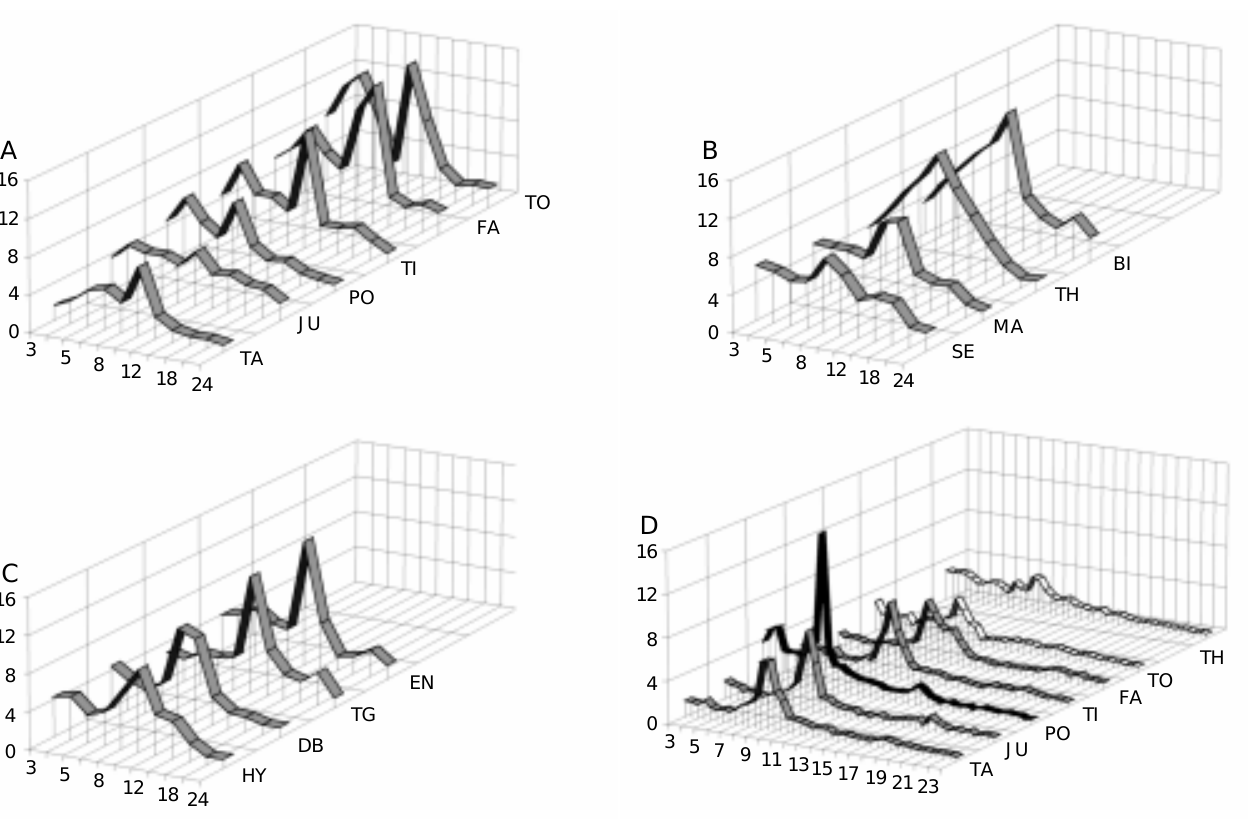
Figure 4. Individual driving profiles (first harmonic in the first series of intermittent photic stimulation) classified according to the reaction in the theta band (see Figure 1). The abscissae show the frequency of the EEG and stimulation, in Hz; the ordinates show amplitude spectra, in µv/ etc., indicate the subjects. A , Six subjects with theta peak amplitudes exceeding half their maximum in the alpha band. B , Four subjects without theta peak, but with amplitude maxima in the theta band exceeding half their maximum in the alpha band. C , Four subjects with amplitude maxima in the theta band less than half their maximum in the alpha band. D , Initial background EEG spectra of subjects in group A, and one from group B (TH - who did not show a dominating alpha peak in the resting